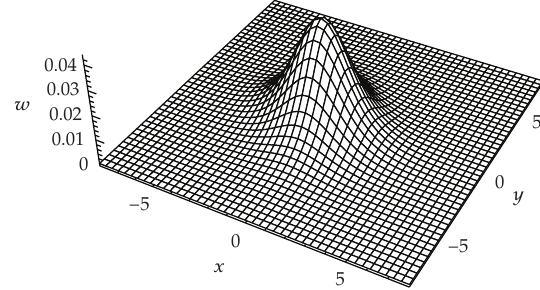
Figure 2: A typical spatial structure for (cid:2) 4.8 (cid:4) with A (cid:8) 2.